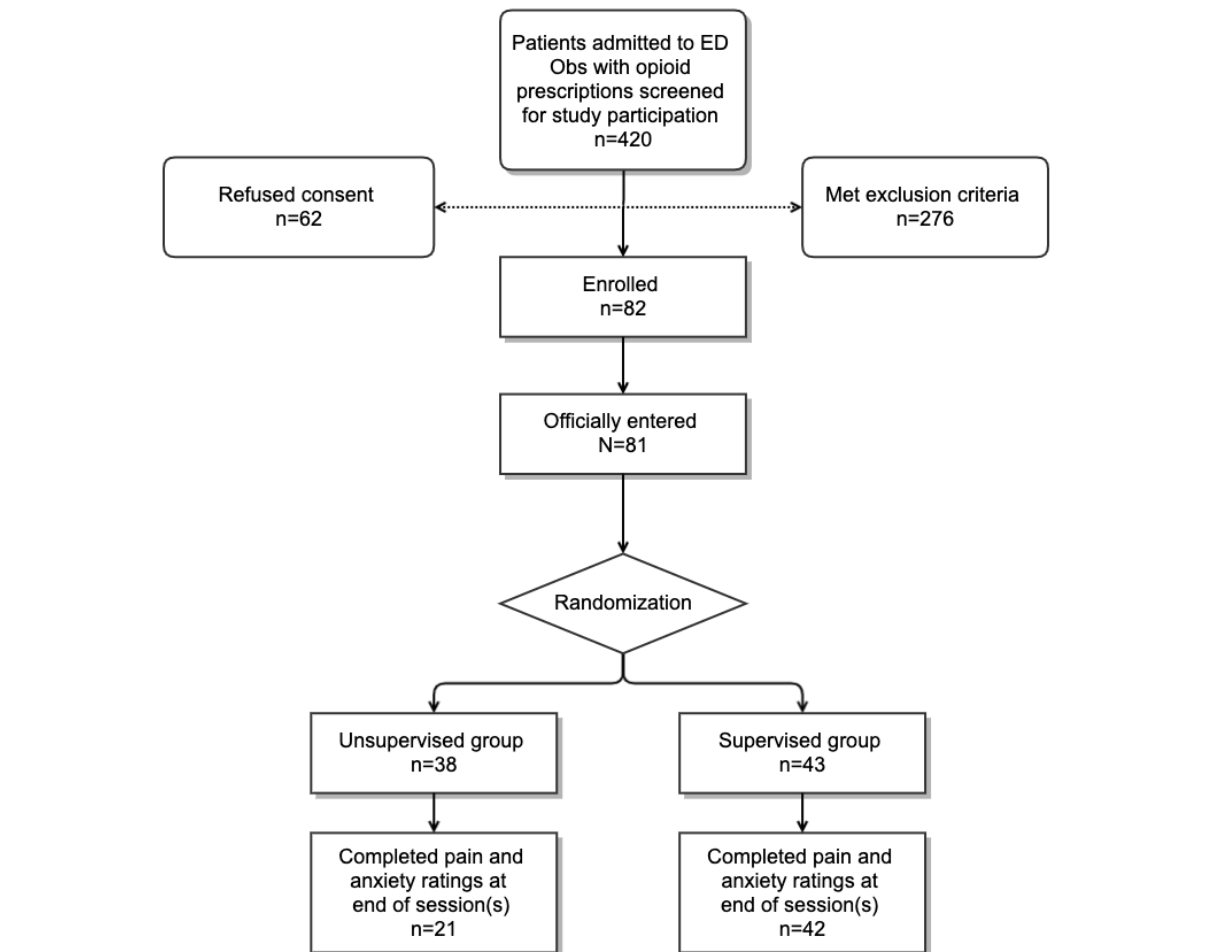
Figure 1. Study flow diagram. ED Obs: emergency department observation